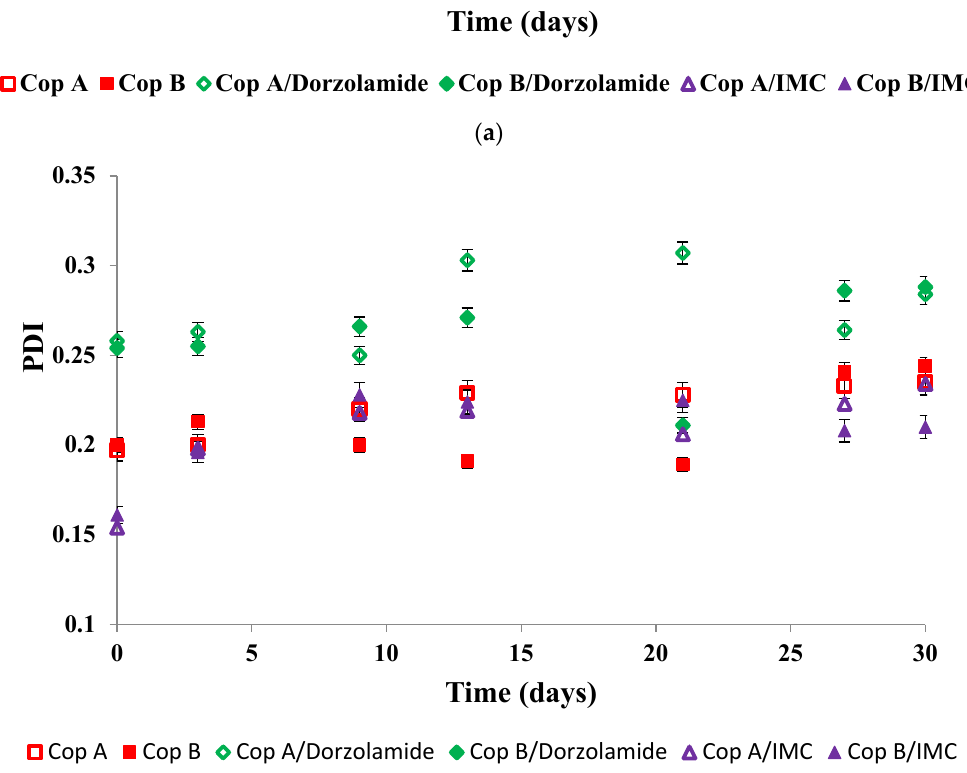
Figure 2. Evolution of both Z-average and PDI as a function of time for drug-free ( a ) and drug-loaded ( b ) PMs at a copolymer/drug ratio of 10/1.